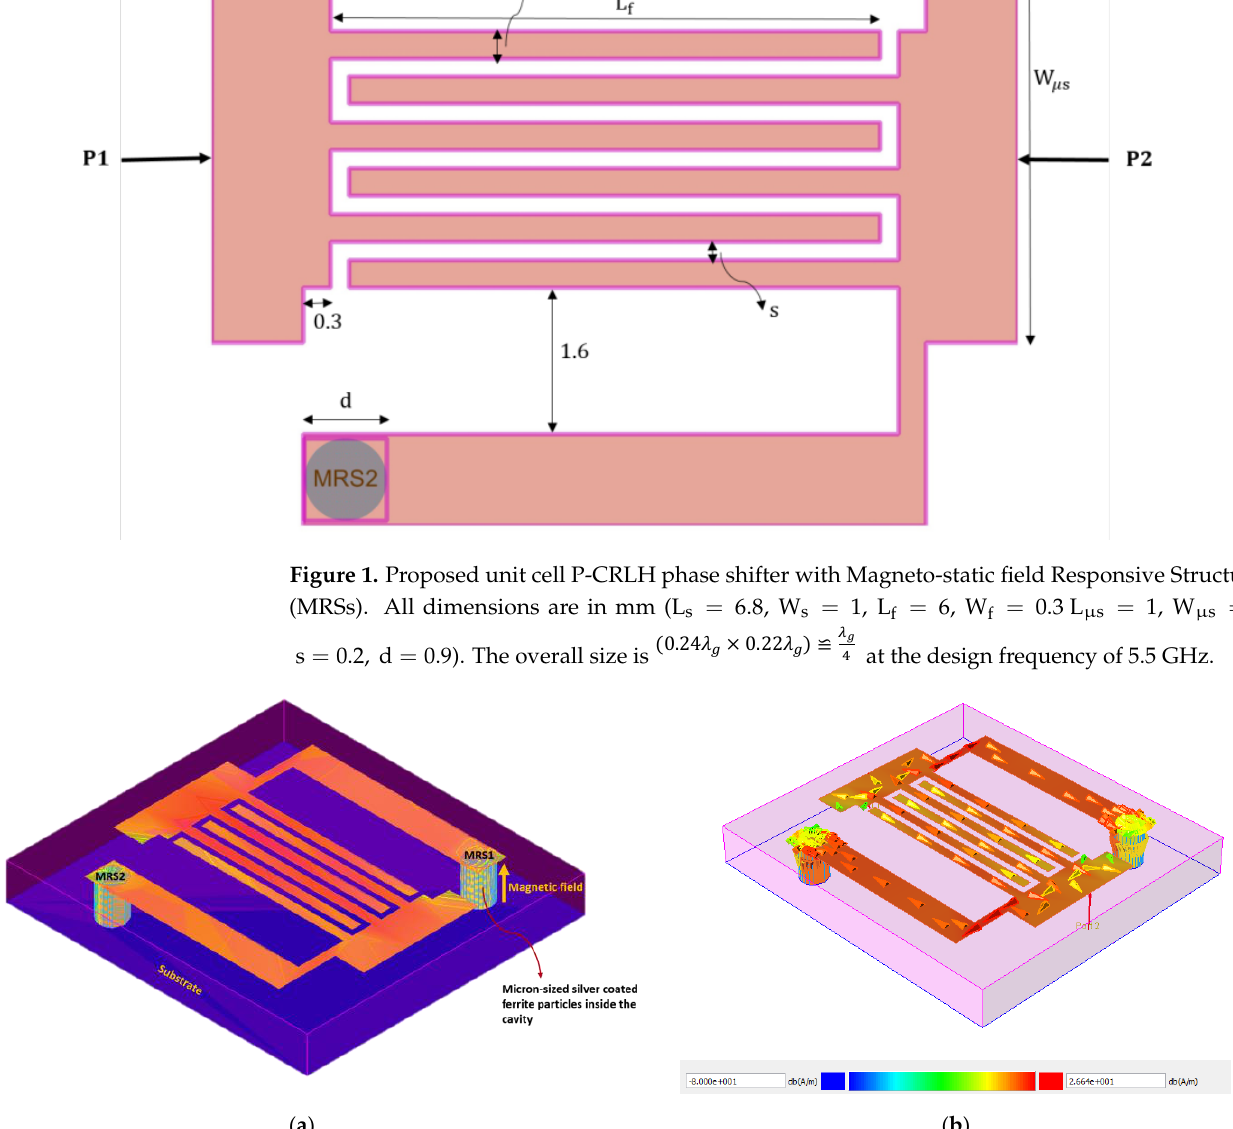
Figure 2. Isometric view of the proposed unit cell P-CRLH phase shifter with ( a ) magnetic alignment of particles in Magneto-static field Responsive Structures (MRSs); ( b ) Surface current distribution at 5.5 GHz when particles inside the MRS are activated.